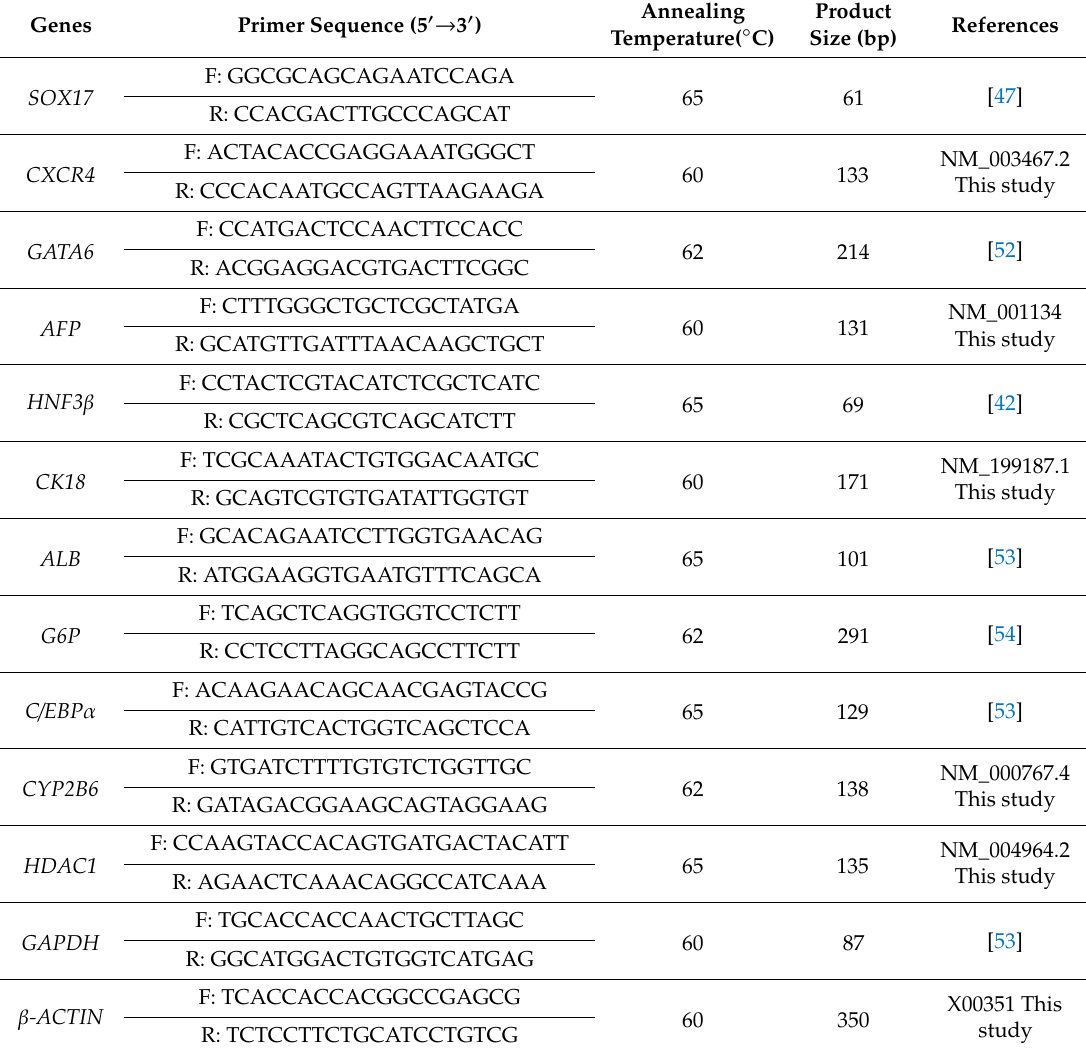
Table 1. Primers used for RT–PCR